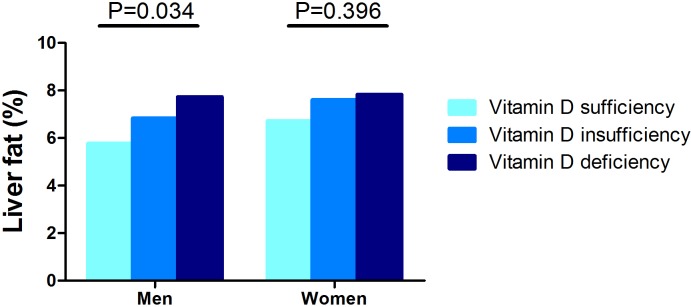
The average LFC (%) in male (left) and female (right) subjects with different vitamin D status with a serum 25(OH)D <50nmol/L, = 50–75nmol/L and >75nmol/L. The liver fat content was significantly higher in male subjects with vitamin D deficiency and insufficiency, but not in female subjects.